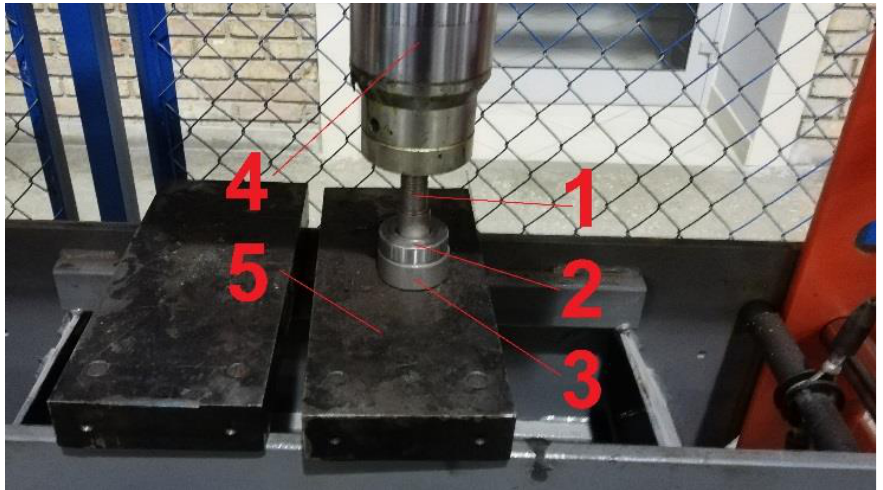
Figure 2. Forming sample process: 1 — stamp, 2 — form, 3 — base, 4 — hydraulic press, 5 — press frame. After drying, the samples were ground using a magnetic grinder. In the research method that was used, it is important that the surface has the lowest possible roughness, preferably below 0.5 Ra; a value of ~0.32 was obtained for all samples (9th class). One sample of each group is presented in Figure 3.